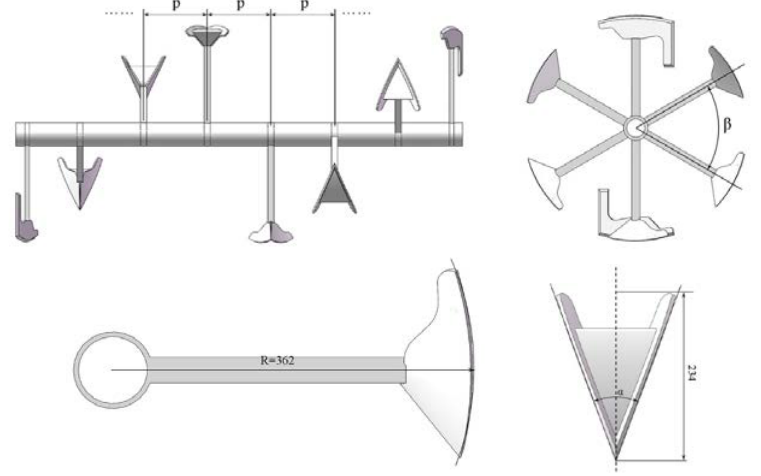
Fig. 2. The refined structure for mixing.